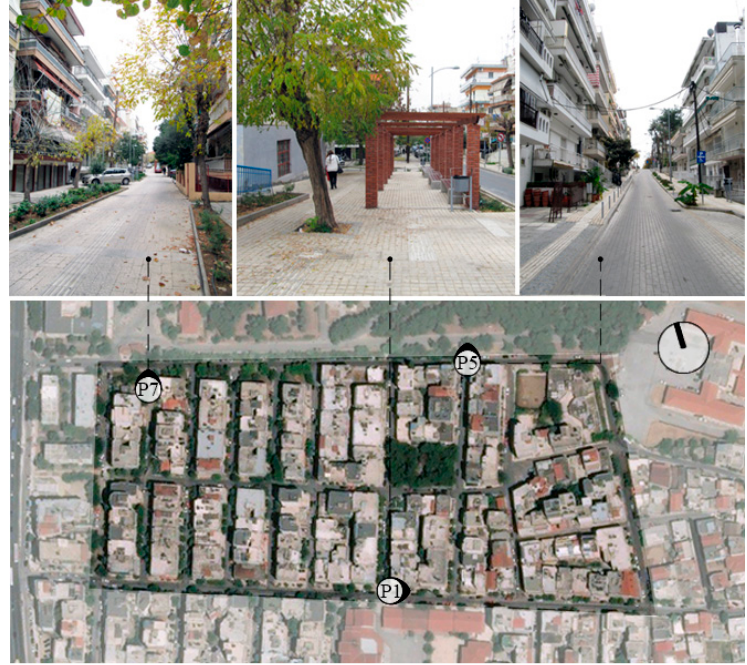
Figure 1. The study area in Pavlou Mela, Thessaloniki of Greece Streets Views: P7_Varnali, P1_G. Lampraki, P5_Papanaastasiou.